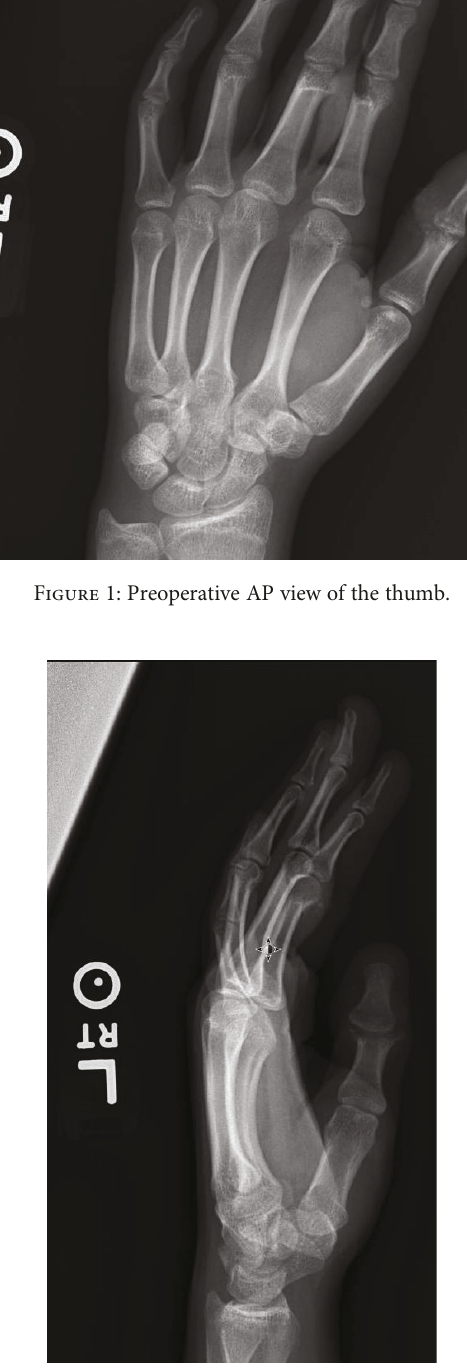
Figure 2: Preoperative lateral view of the